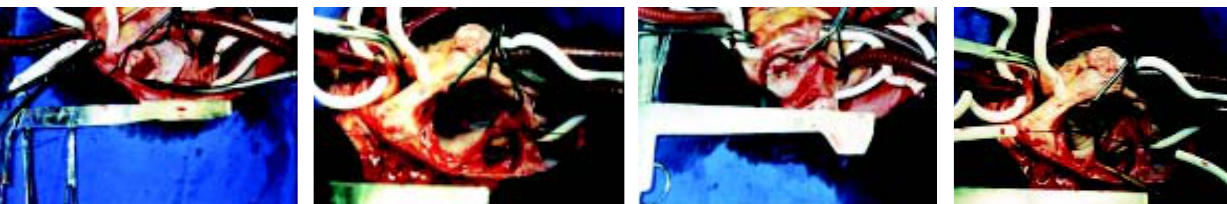
Fig. 1 - Aspectos cirúrgicos da técnica de anuloplastia. (A) – Valva mitral insuficiente / (B) – Sutura contínua dupla no anel mitral / (C) – Medida do diâmetro desejado / (D) – Aspecto final associado à quadrantectomia do folheto